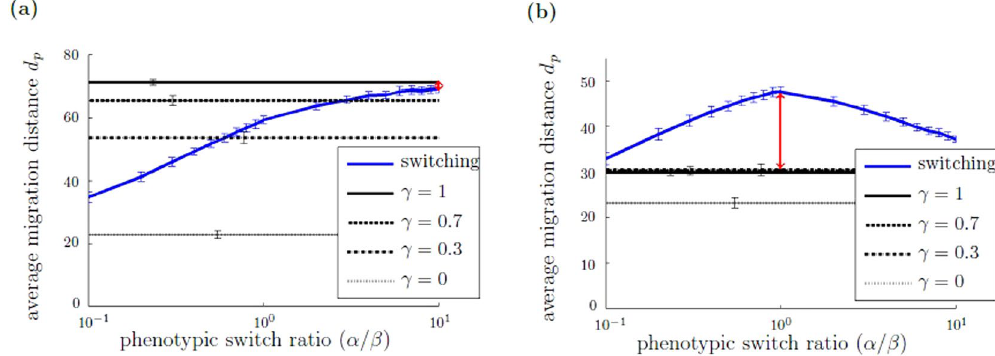
Figure 5. Migration plasticity can be advantageous under heterogeneous, highly structured ECM conditions. The figure shows the average migration distance d p of switching and non-switching populations depending on the switch ratio α / β under heterogeneous ECM condition (modeled by equation (2) with θ = 0.5, see Fig. 3(e)) and with different migration rate ratios: ( a ) c M / c A = 0.75 and ( b ) c M / c A = 0.25. The blue line represents the switching populations, the black lines display non-switching populations with different M -cell fraction γ ∈ . . {0,0 3,0 7,1} . Each simulation is run with 50 cells. Simulations are evaluated after 200 Monte Carlo steps, averaged over 50 independent simulations. The errorbars show the standard deviation of the average migration distance d p between the simulations. The standard deviation within the simulations is shown in Supplementary Fig. S6. Simulation parameters are κ = 1, δ = . 0 1 . The red arrow indicates the difference Δ d p between the switching population with maximum average migration distance d p with respect to varied α / β ratio and the non-switching population with maximum d p with respect to varied γ fraction, which is the observable analyzed in Fig.